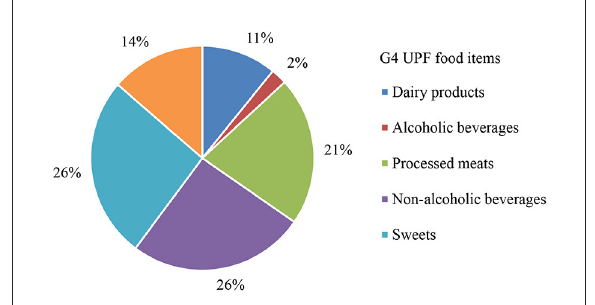
FIGURE1 Pie chart showing the proportion (in % kcal/day) of UPF consumption (group 4 of the NOVA classification system) in the total diet of the study